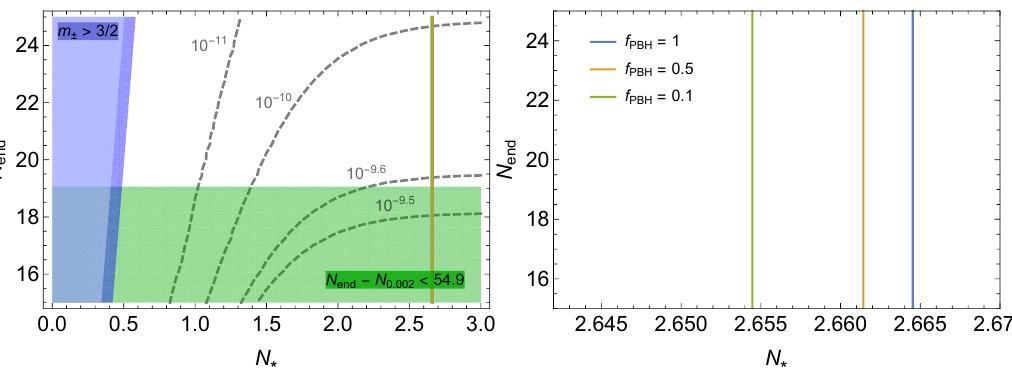
Figure 8 . The parameter scan of PBH-baryon production from USR inflation with δ 2 = − 3 . 05 in the { N plane, where N = 0 is chosen at the onset of USR transition in figure 1. The ∗ , N end } PBH-to-dark matter ratio f ( N ) = 0 . 1 , 0 . 5 , 1 is estimated by the monochromatic relation PBH ∗ , N end M H = M PBH . Initial conditions for σ ± ( N ∗ , N end ) are computed by (2.14) based on the constant- mass approximation with { c = {− 2 , 1 , 1 } , m = H 2 , and Λ = 0 . 3 M . The contours 1 , c 2 , c 3 } σ ∗ / P are the final baryon asymmetry | Y resulting from the given initial conditions { N , where B | ∗ , N end } m I = 20 H ∗ and Γ I = 10 13 GeV are taken in the reheating scenario. Colored regions in the left panel are excluded by the minimal e -fold number of single-field inflation and the condition m 3 / 2 ± /H ∗ < for the late-time approximation of (2.14). Right panel: a zoom-in for the ratio f ( N ) on PBH ∗ , N end the N ∗